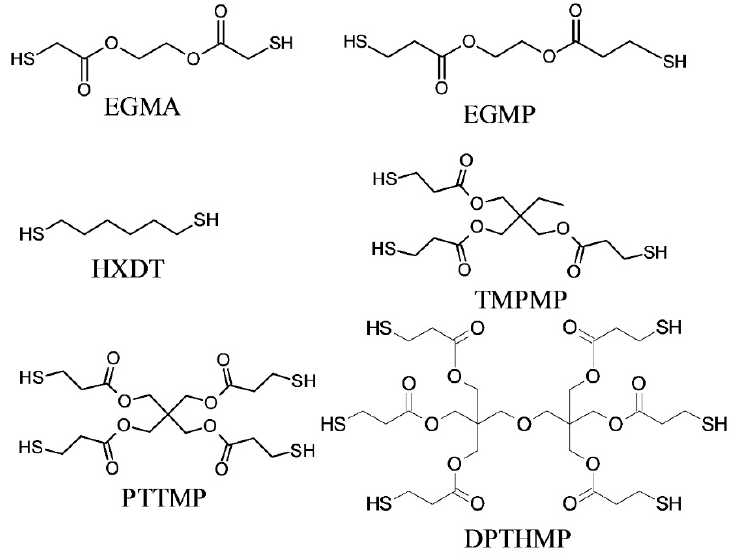
Figure 23. Structures of selected commercially available thiols.